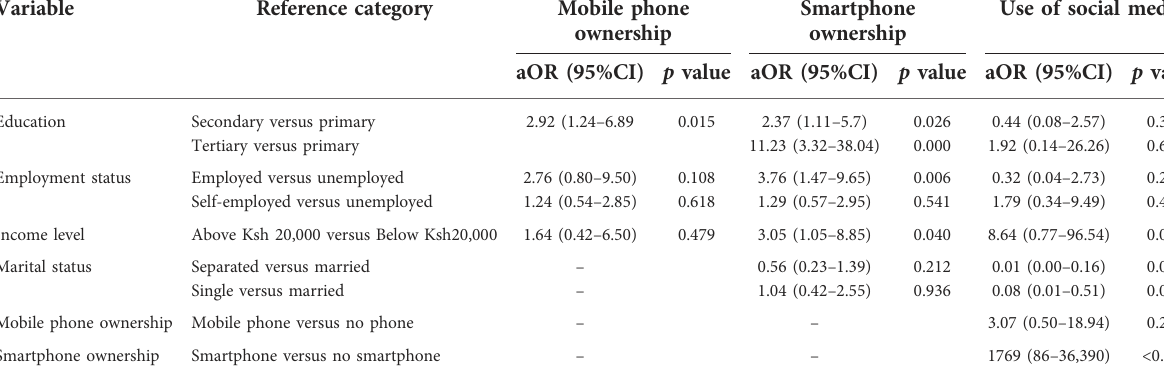
TABLE 6: Factors associated with mobile phone ownership and other digital technology use on multivariate analysis.